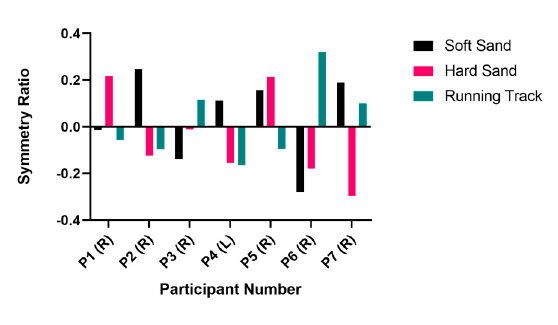
Figure 5. Symmetry ratio calculated for participants on each running surface, positive shows left dominance, negative shows right dominance; (R) and (L) denotes the foot dominance of each